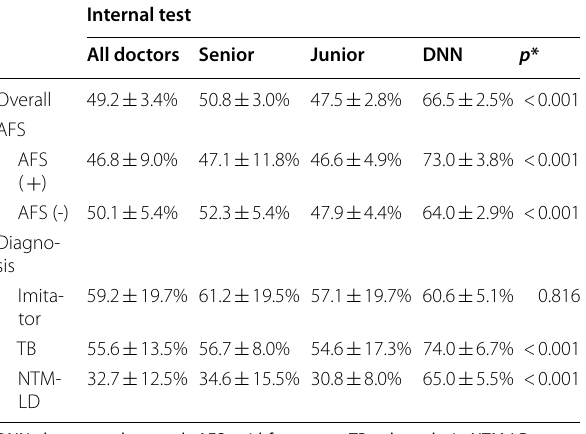
DNN, deep neural network; AFS, acid-fast smear; TB, tuberculosis; NTM-LD, nontuberculous mycobacterial lung disease p * compared between all doctors and DNN on diagnosis accuracy